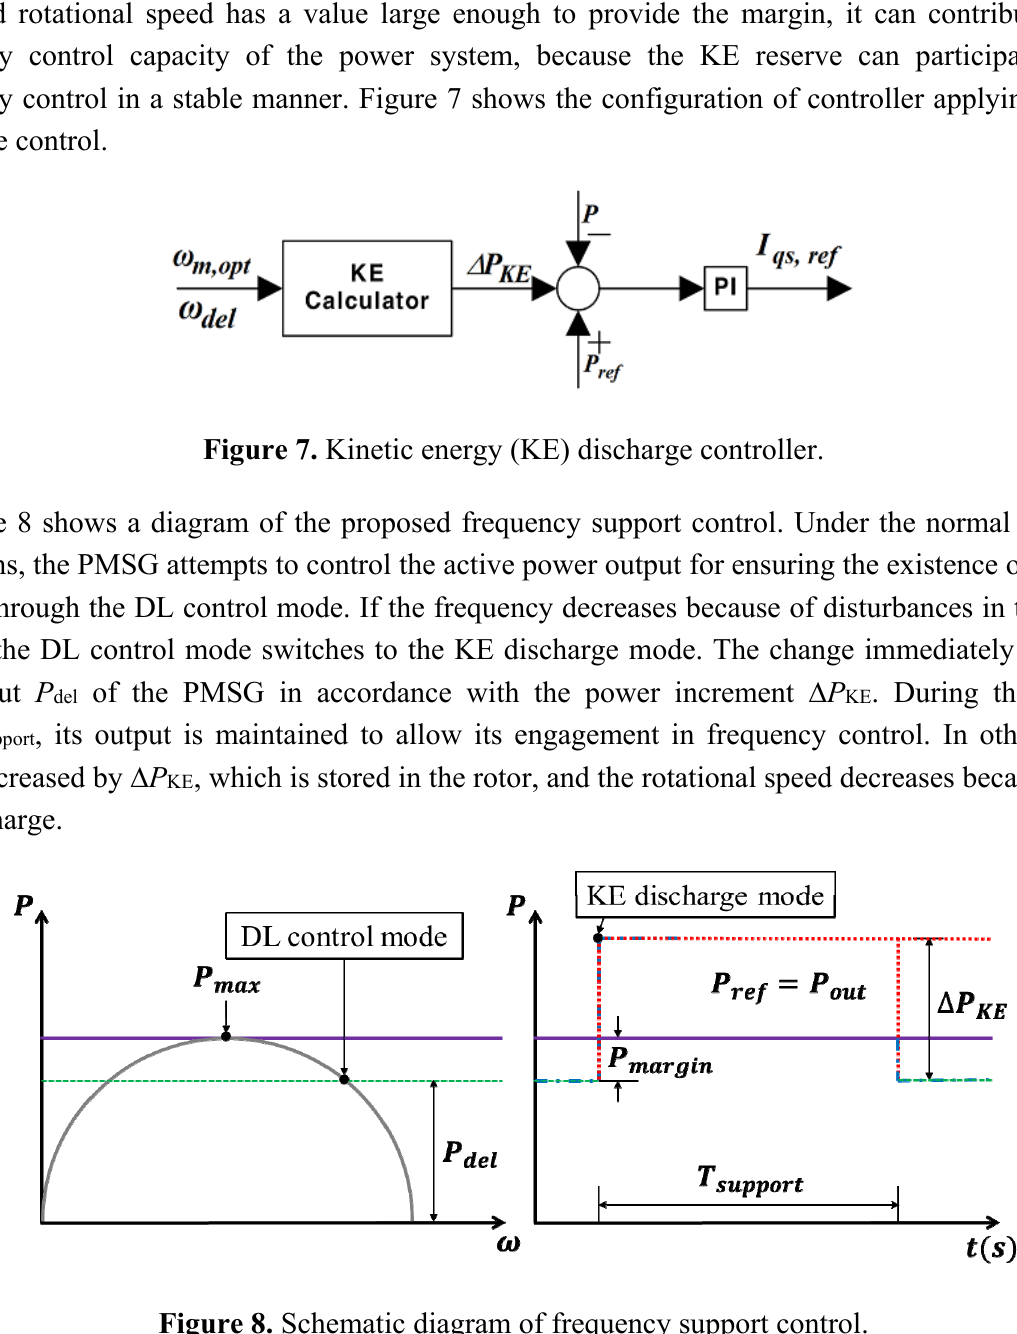
Figure 8. Schematic diagram of frequency support